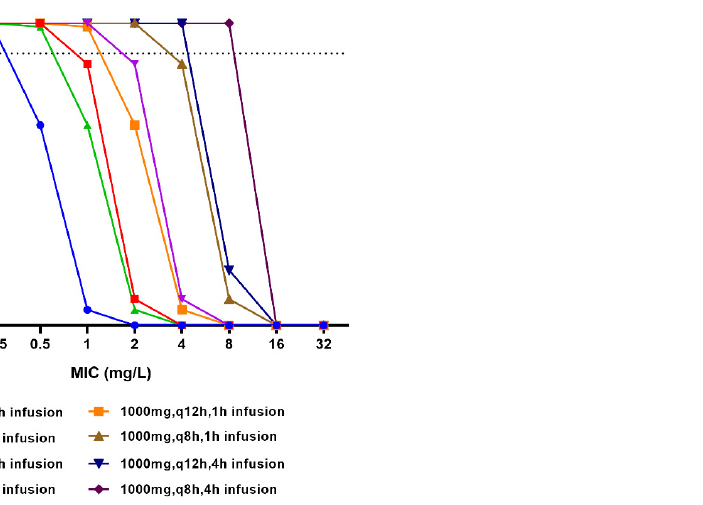
6 of 12 Figure 4. Goodness-of-fit plots for the final pharmacokinetic model. ( A ): Plot of observed concen- trations versus population predictions. ( B ): Plot of observations versus individual predictions. ( C ): Conditional weighted residual versus population predictions. ( D ): Conditional weighted residual versus time. The open circles show observations. The red line shows smooth fitting for observations. Figure 5. Visual predictive check plots for the doripenem concentration in plasma with different dosing regimens. Open circles represent observed concentrations. The red line represents the me- dian of the observations. The red dashed lines represent the 5th and 95th percentiles of the observa- tions. The blue shaded areas represent the 90% confidence intervals for the 5th and 95th percentiles, and the orange shaded areas represent the median of the predicted data. 2.5. Pharmacokinetics/Pharmacodynamics The probabilities of target attainment (PTAs) for different dosing regimens using the Monte Carlo simulations are shown in Figure 6. It shows that 1 h intravenous infusion with doripenem at 0.25 g every 12 h or 8 h could reach PTA ≥ 90% for pathogens with MIC ≤ 0.25 mg/L or 0.5 mg/L, respectively. As shown in Figure 5, 1 h intravenous infusion with